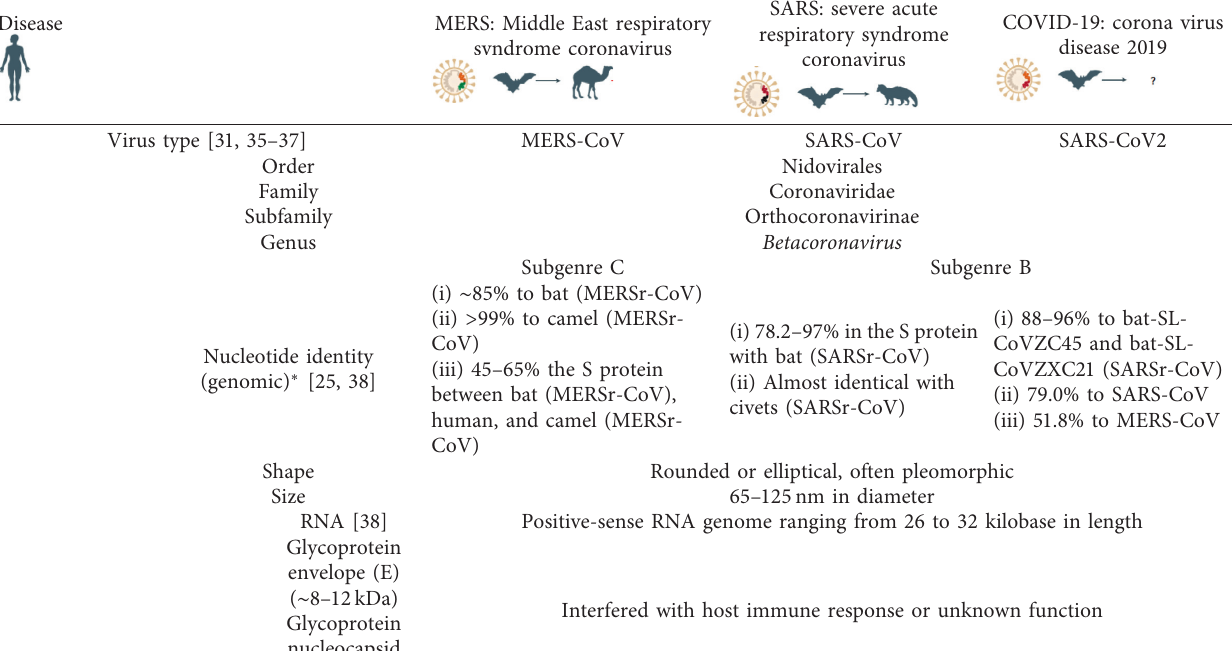
Table 1: Comparison chart of MERS with SARS and